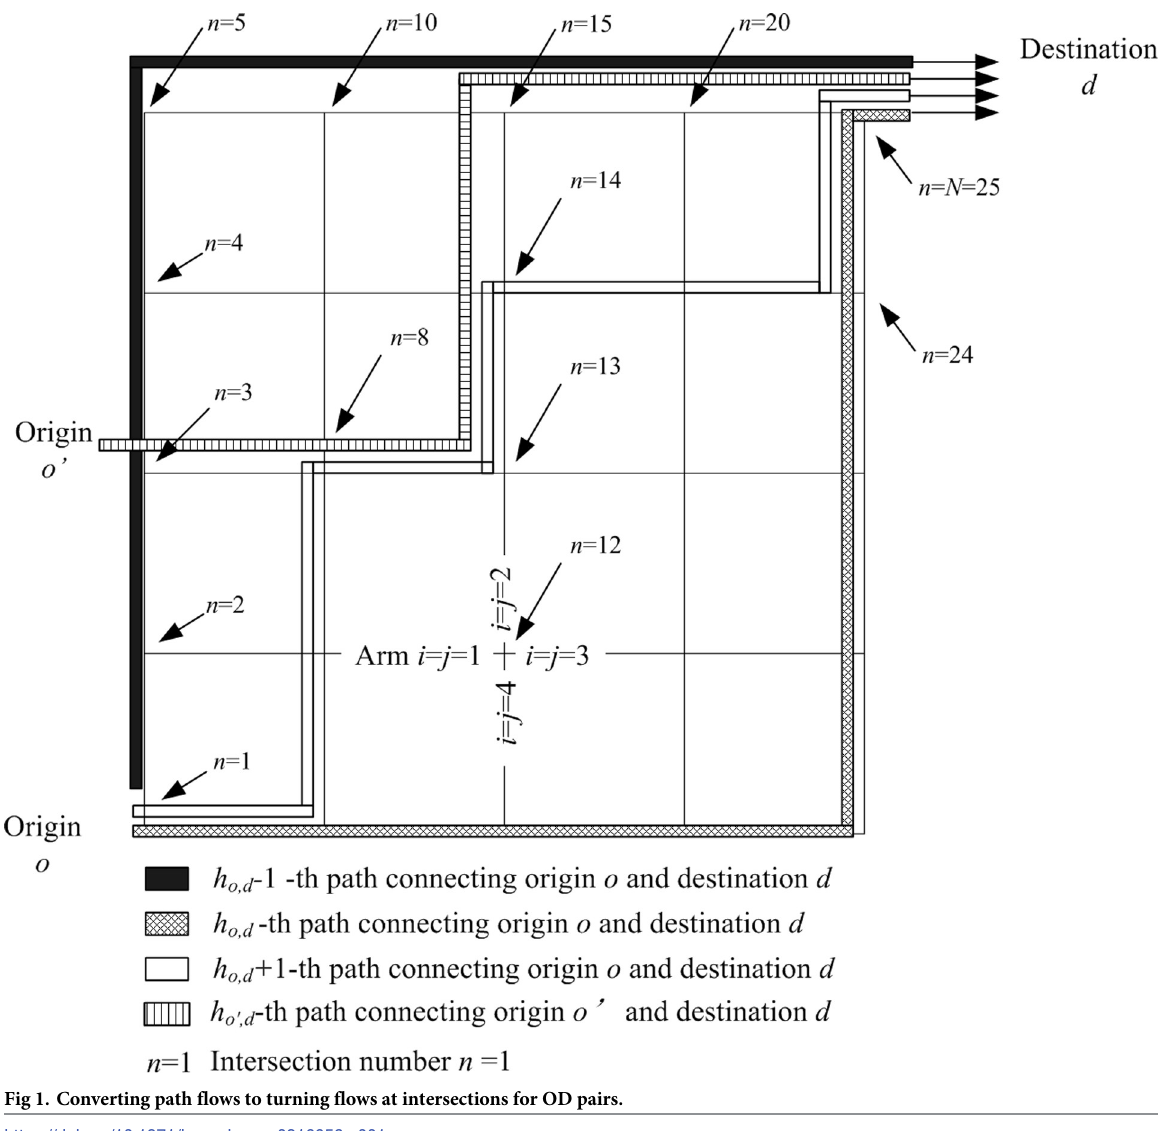
Fig 1. Converting path flows to turning flows at intersections for OD pairs.